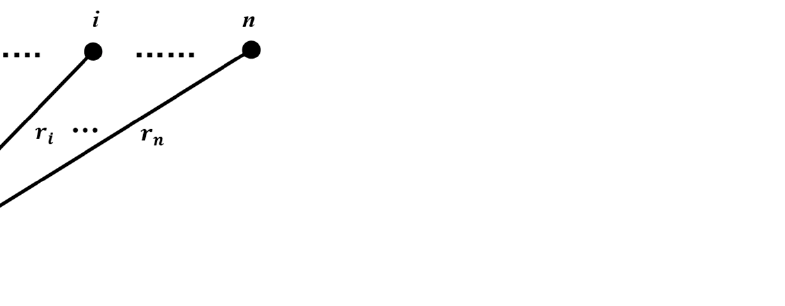
Figure 3. The point P ( r , θ ) in the sound field and its relative position to n elements of the linear array.